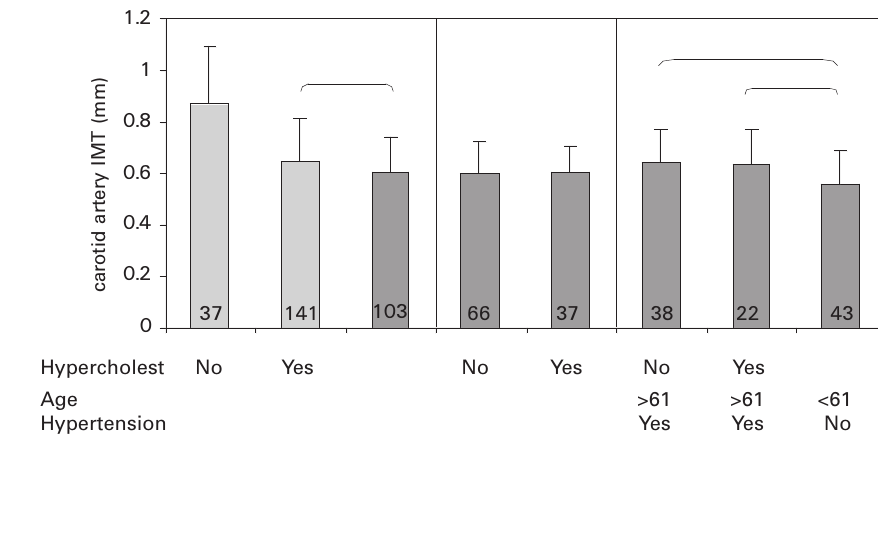
The intima-media thickness of 103 consecutive patients with primary biliary cirrhosis was sig- nificantly lower than that measured in 141 con- trol patients without hypercholesterolaemia and 37 patients with hypercholesterolaemia and no PBC (left panel). Among the patients with PBC, there was no difference between the intima-media thickness of patients with hyper - cholesterolaemia and those without hypercho- lesterolaemia (middle panel). However, among the patients with PBC, those with hypertension and age above 61 years had greater intima- media thickness, independently of hypercholes- terolaemia, than those aged under 61 years without hypertension (right